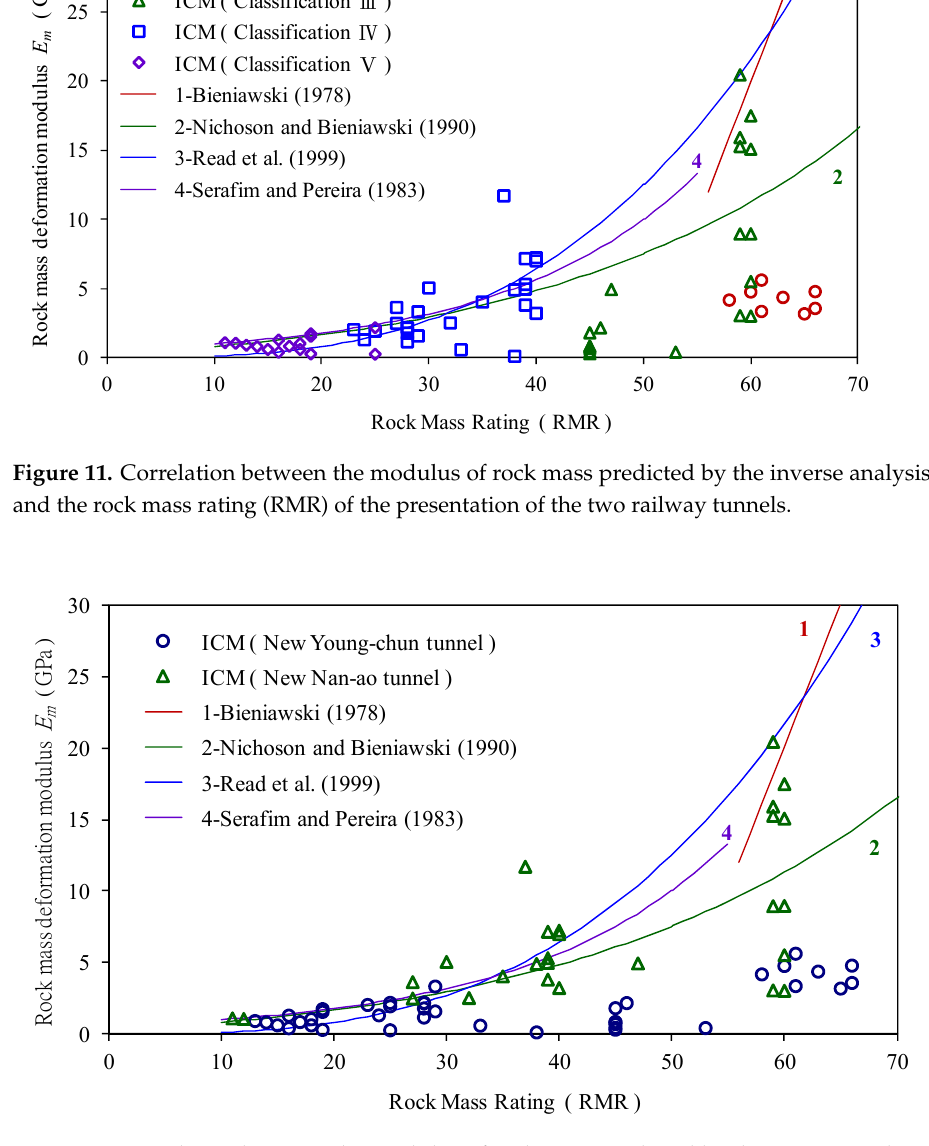
Figure 12. Correlation between the modulus of rock mass predicted by the inverse analysis (ICM) and the rock mass rating (RMR) of the presentation of the two railway tunnels.